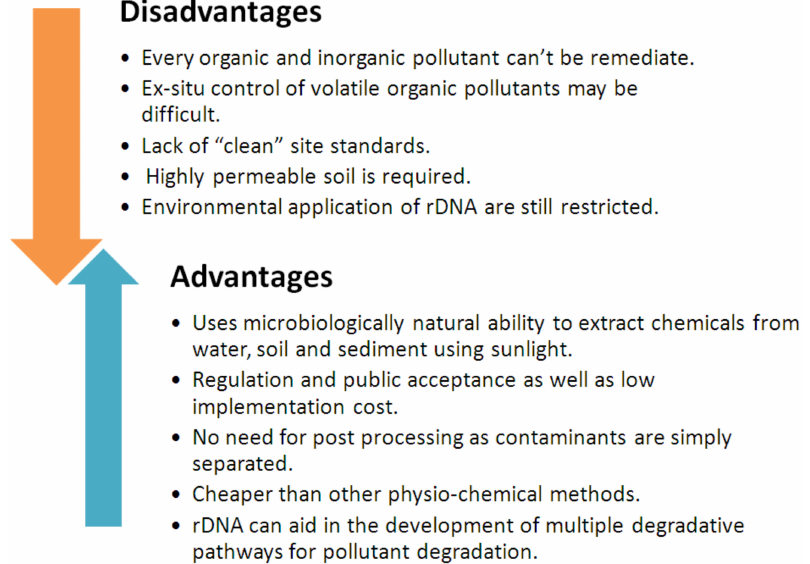
Figure 2. Advantages and disadvantages of